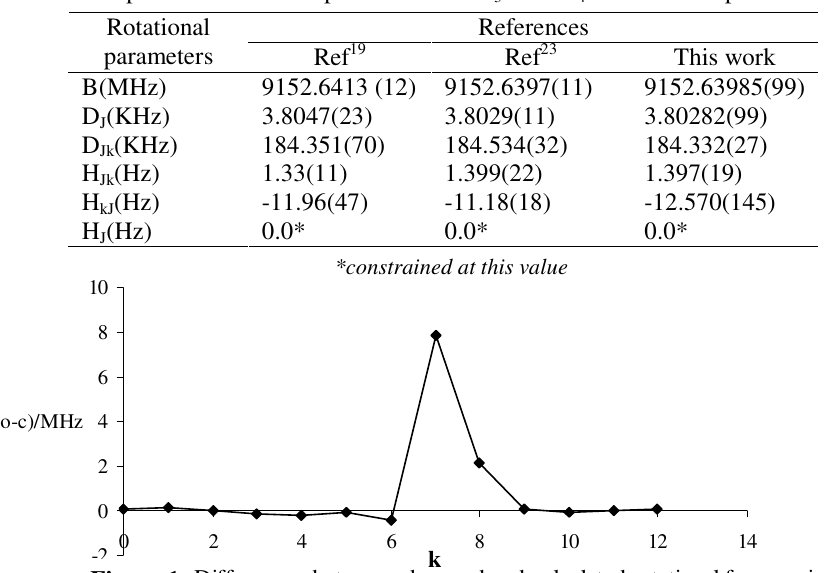
Table. 9. Comparison of rotational parameters of CH